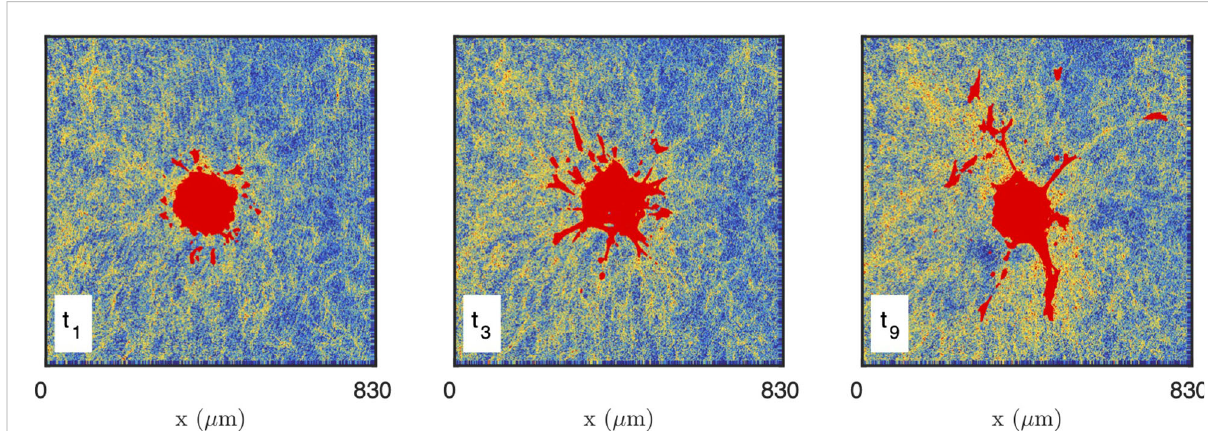
FIGURE 8 Images of the CAF spheroid and surrounding gel at various times: t1 = 30 min, t3 = 210 min, t9 = 750 min. The images correspond to one height z cutting through the spheroid, with the cells shown in red and the density of the gel coded from blue (low density) to yellow (high density).